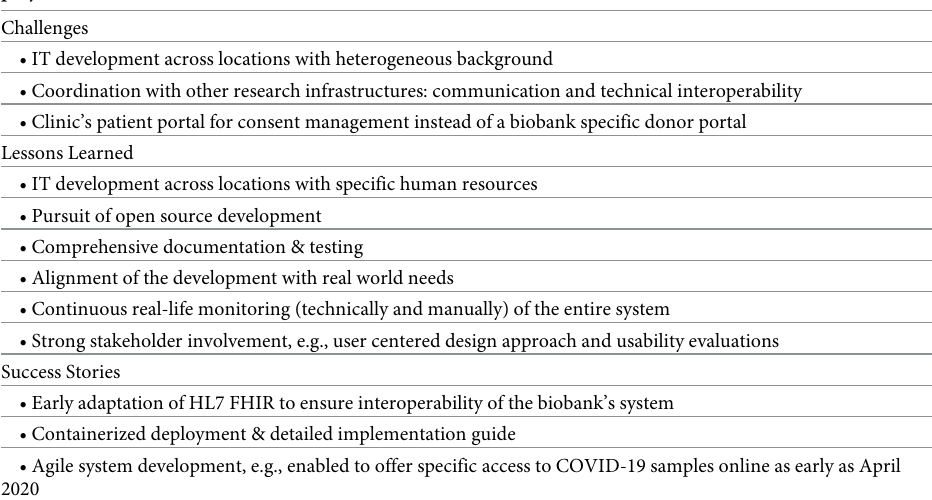
Table 1. Short summary of challenges, lessons learned, and success stories we encountered during the GBA